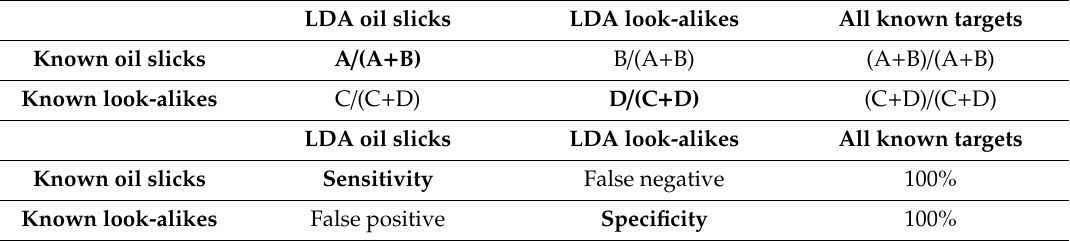
Table 2. “Horizontal” analysis of the confusion matrix shown in Table 1 with some of the supplementary measures used to evaluate our Linear Discriminant Analyses